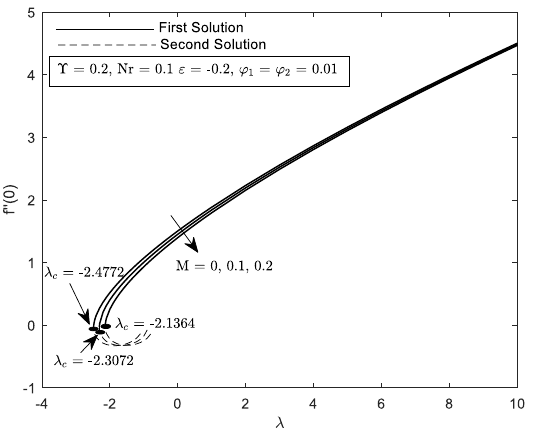
Figure 4. Variation of 𝑓 ′′ (0) with mixed convection parameter, 𝜆 for several values of M.